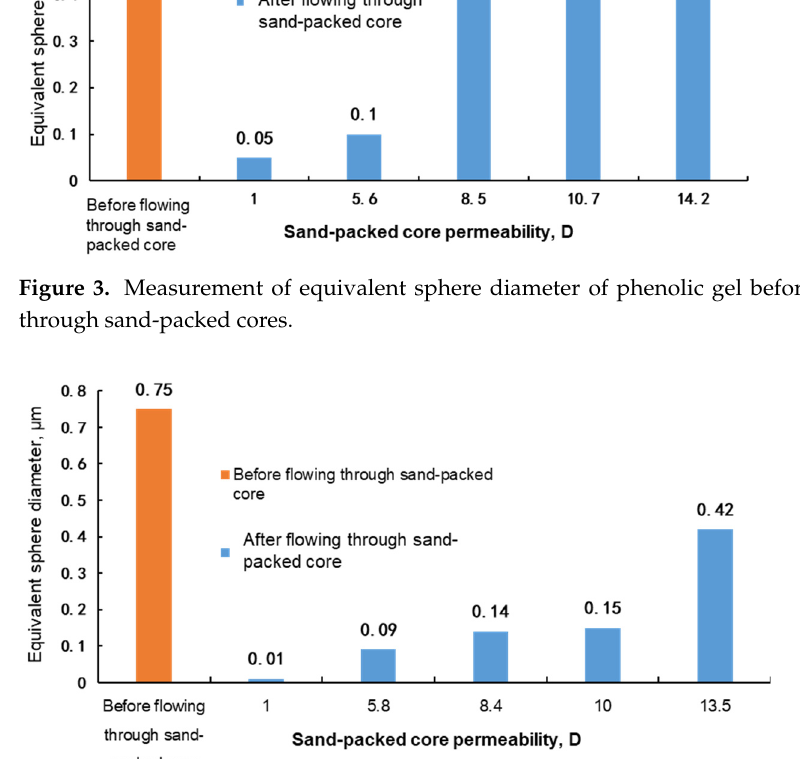
Figure 4. Measurement of equivalent sphere diameter of aluminum gel before and after flowing through sand-packed cores.